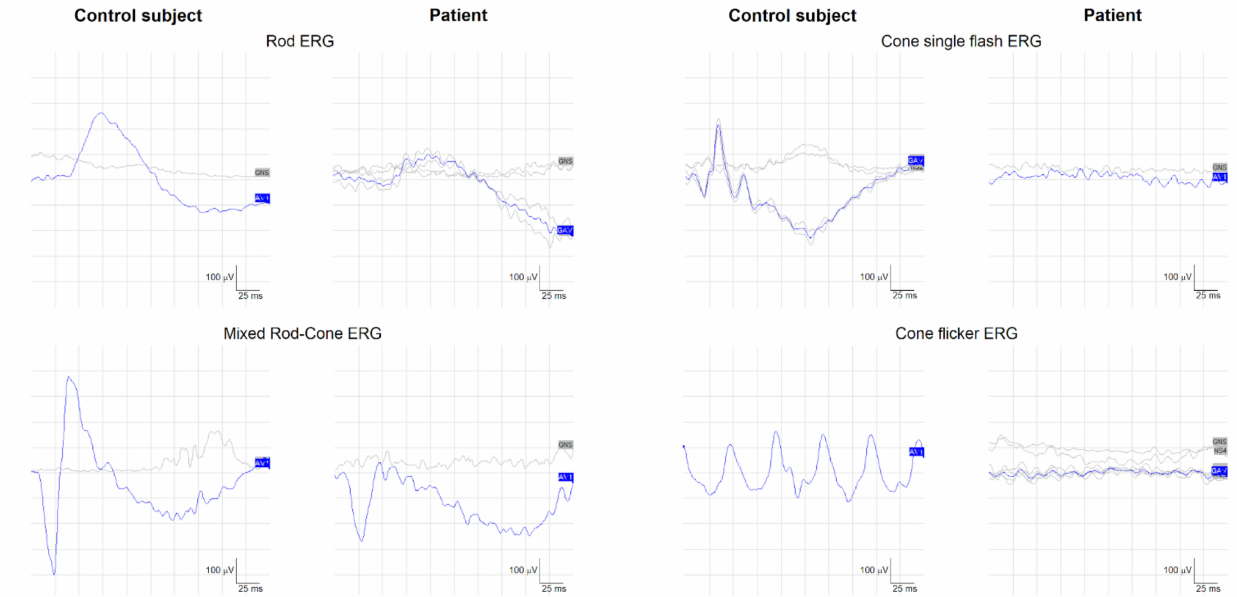
Figure 2. Standard electroretinography recorded in a control subject (a 48-year-old female, left columns) and in the study patient (right columns). Note that cone ERGs were unrecordable in the patient. Rod ERGs showed reduced b-wave amplitude and a lower-than-normal b/a wave amplitude ratio in the dark-adapted mixed rod-cone